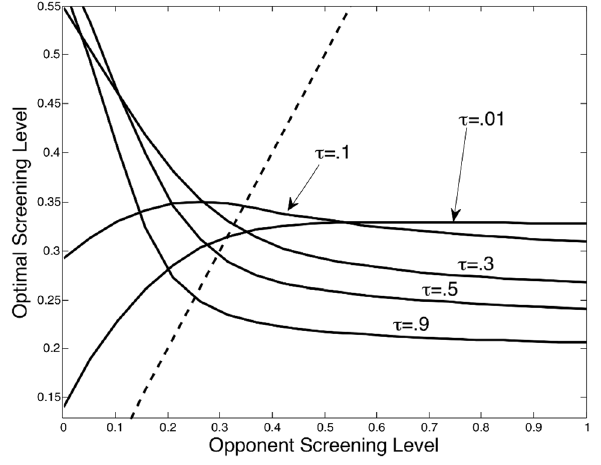
Figure 3. Changing the level of treatment efficacy. The shape of the best response curve and the equilibrium screening level are influenced by the level of treatment efficacy t . As treatment becomes more effective ( t increases), the best response curve shifts from an increasing concave function to a decreasing convex function. The equilibrium screening level decreases as treatment becomes more effective from t ~ : 1 to t ~ : 9 .